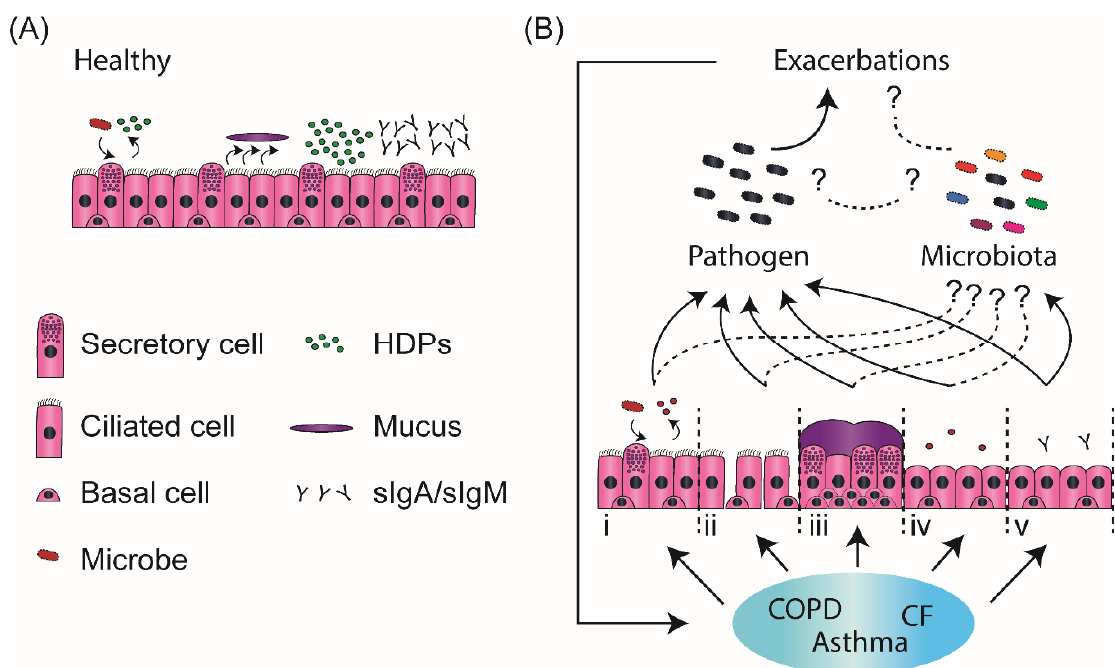
Figure 1. Summary of processes that contribute to the increased frequency of respiratory infections in patients with chronic inflammatory lung disease. The healthy epithelium exerts an array of host defence activities that contribute to the prevention of pathogen invasion: it forms a tight and physical barrier, secretory cells that include club cells and goblet cells contribute to the production of host defence molecules such as host defence peptides and proteins (HDPs), ciliated cells in combination with the mucus produced by the goblet cells promote mucociliairy clearance, and transport of IgA and IgM across the epithelium allows sufficient secretory IgA/IgM (sIgA/sIgM) to be present in the lumen to contribute to immune exclusion ( A ). In patients with chronic obstructive pulmonary disease (COPD), asthma, or cystic fibrosis (CF) several of these processes are disturbed and contribute to an enhanced frequency of respiratory infections: (i) Chronic inflammation alters epithelial responses to pathogens through impaired cytokines/chemokines secretion and decreased HDPs secretion and/or activity. (ii) Chronic inflammation leads to impaired barrier function of the airway epithelium allowing bacterial invasion of the airways. (iii) Changes in mucus secretion, composition and rheology as well as goblet cells metaplasia in a chronically inflammed epithelium leads to impaired mucociliary clearance, resulting in outgrowth of potenial pathogenic bacteria. (iv) Airway epithelial remodelling can lead to the reduction of HDP-producing cells, facilitating bacterial colonisation. (v) IgA/IgM transport across the airway epithelium to the mucosal secretions may be impaired as a result of changes in pIgR expression during chronic inflammation ( B ). While these processes have been shown to affect pathogen invasion and growth, it is still unclear how they impact microbiota composition and further increase respiratory infection risks.